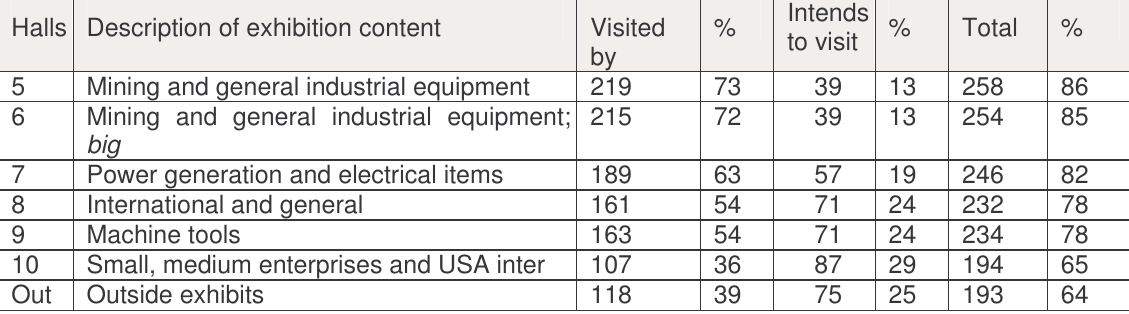
Table 3: Exhibition halls visited at the time of interviews in 2006 Halls Description of exhibition